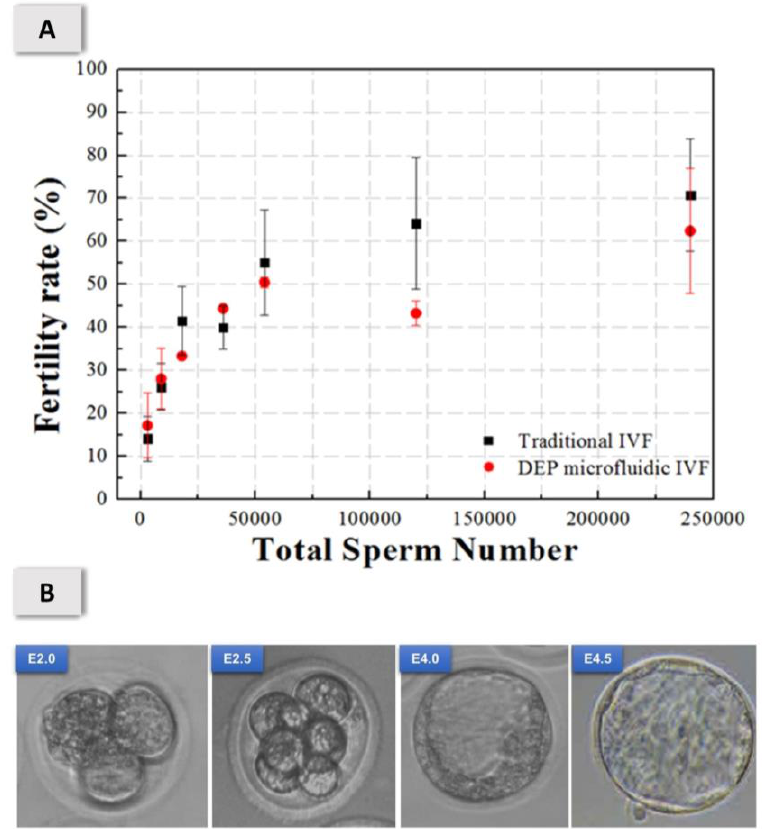
Figure 5. ( A ) Rate of fertilization in vitro of a DFP microfluidic chip compared with traditional IVF at sperm concentrations of 3000 – 240,000 sperm. ( B ) Tracking of embryo development observed with an optical microscope; magnification 40×. The blastocyst rate was 33.6 ± 15.0% ( n = 26) of the DEP microfluidic IVF chip, compared with 37.4 ± 8.0% ( n = 34) of the traditional droplet-based